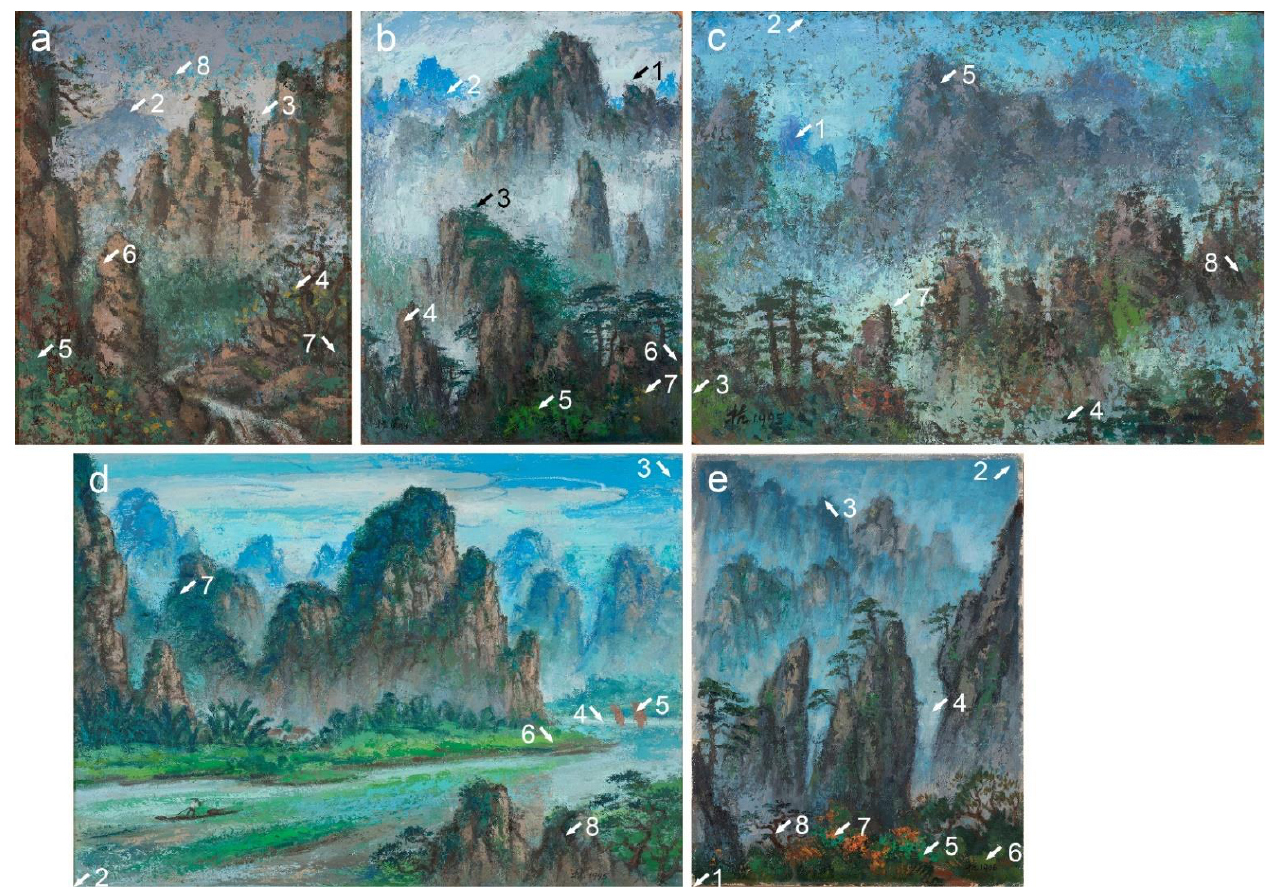
Figure 2. Paintings by Liu Kang: ( a ) Mount Huangshan , 1993, oil on board, 40.5 × 31.7 cm; ( b ) Mount Huangshan , 1994, oil on board, 78.5 × 58.3 cm; ( c ) Mount Huangshan , 1995, oil on board, 30.5 × 40.5 cm; ( d ) Mountain , 1995, oil on canvas, 84.7 × 118.5 cm. ( e ) Mount Huangshan , 1996, oil on canvas, 64 × 49 cm. Gifts of the artist’s family. Collection of National Gallery Singapore. Arrows and numbers indicate sampling areas. Table 1. Inventory and technical information of the paintings by Liu Kang included in this study.